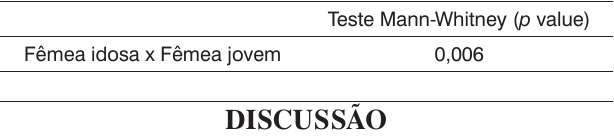
Tabela 3. Teste de Mann-Whitney aplicado na comparação dos